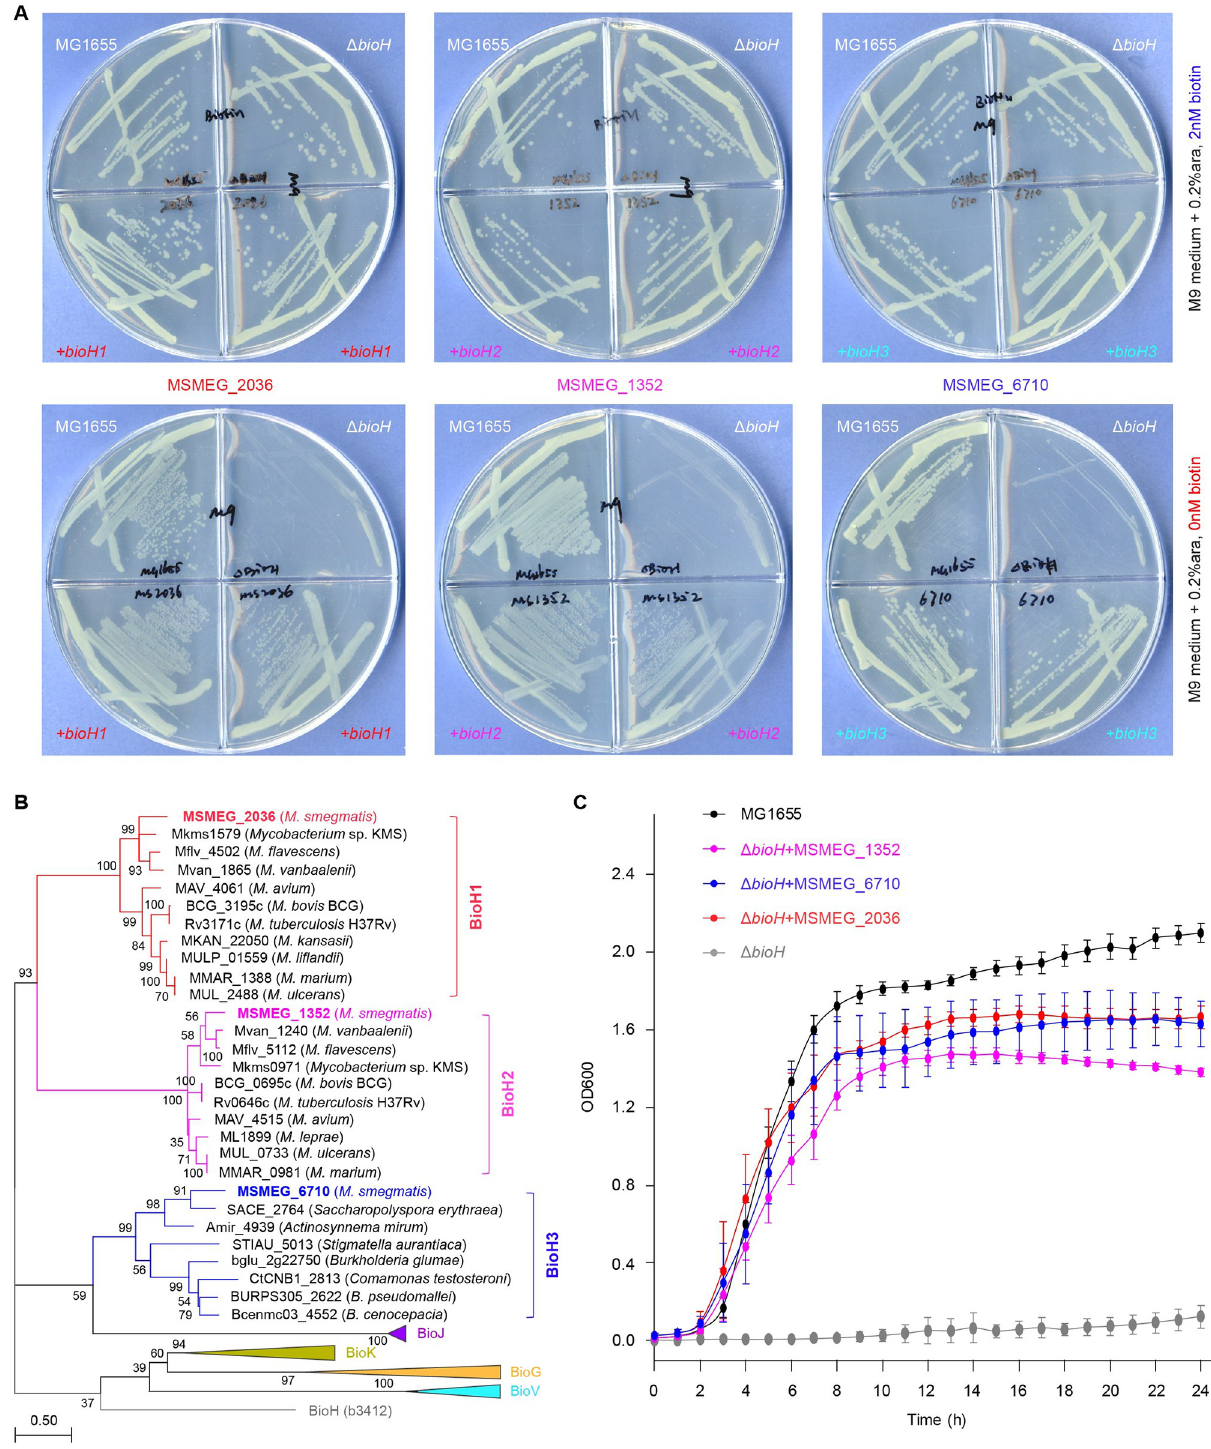
Fig 2. Expression cloning discovered three distinct M . smegmatis genes displaying BioH-like activities. A. M . smegmatis possesses three distinct genes whose expression consistently enables the recipient host of the E . coli Δ bioH biotin auxotrophic strain to appear on the non-permissive condition lacking biotin. A representative result of three independent experiments was given. Namely, the three BioH-like genes (designated BioH1 to BioH3) of M . smegmatis MC2 155 include MSMEG_2036, MSMEG_1352, and MSMEG_6710. B. Phylogeny of the three BioH isoenzymes (BioH1 to BioH3) from M . smegmatis . Except for BioH enzyme-including subclades, all the other four subtrees were compressed with triangles, which correspond to the